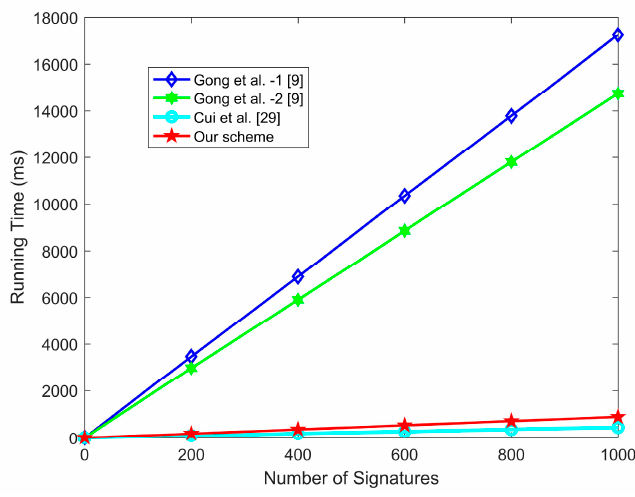
Figure 3. The comparison of aggregate verification time.